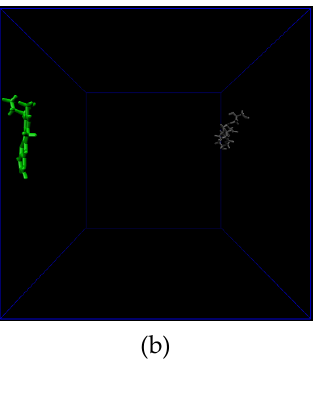
Figure 1. ( a ) Poly(glycerol-adipate) (PGA) (above), SI214, and Camptothecin (CPT) (below) structures; ( b ) ΔA% average of the two nano-formulations calculated against the pure drugs in water.